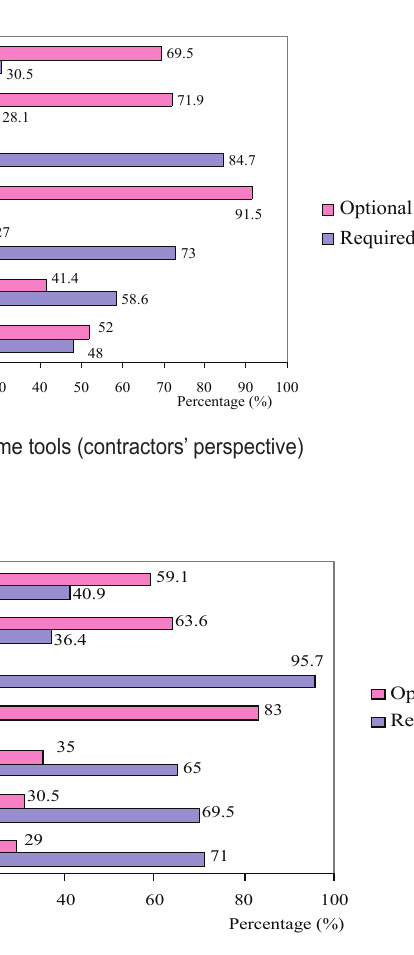
Figure 5: Necessity of time tools (owners’